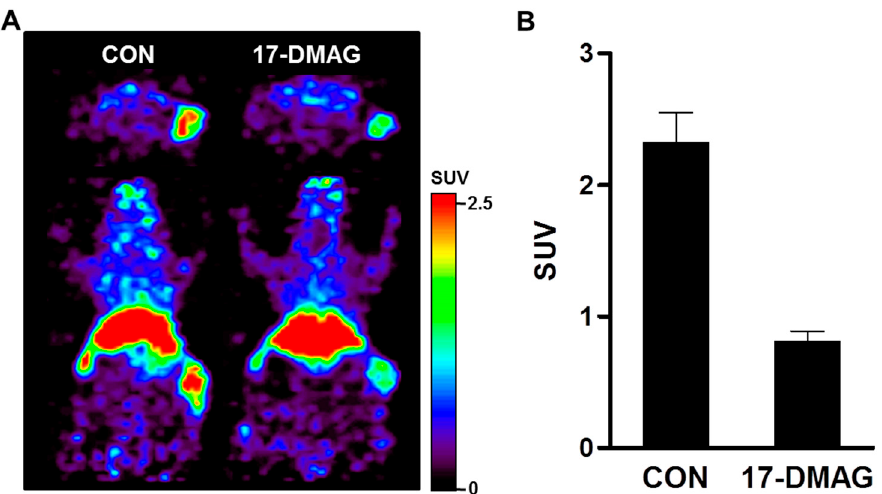
Figure 8. Immuno-PET imaging of 89 Zr-DFO-pertuzumab by treatment of heat shock protein 90 inhibitor (17-DMAG) in JIMT-1 breast cancer xenograft model. ( A ) To evaluate the pharmacodynamics of HER2 expression level by treatment of 17-DMAG, Immuno-PET imaging was performed in the JIMT-1 breast cancer xenograft model. Mice were administered a total of 150 mg/kg of 17-DMAG over 24 h in three doses of 50 mg/kg each. PET images were acquired at 7 days post-injection of 89 Zr-DFO-pertuzumab. Immuno-PET tracer uptake was markedly reduced by treatment of 17-DMAG ( p < 0.0001). ( B ) JIMT-1 tumor uptake of 89 Zr-DFO-pertuzumab as quantified using ASIPro display software. All images and quantitative data were expressed as the standardized uptake value